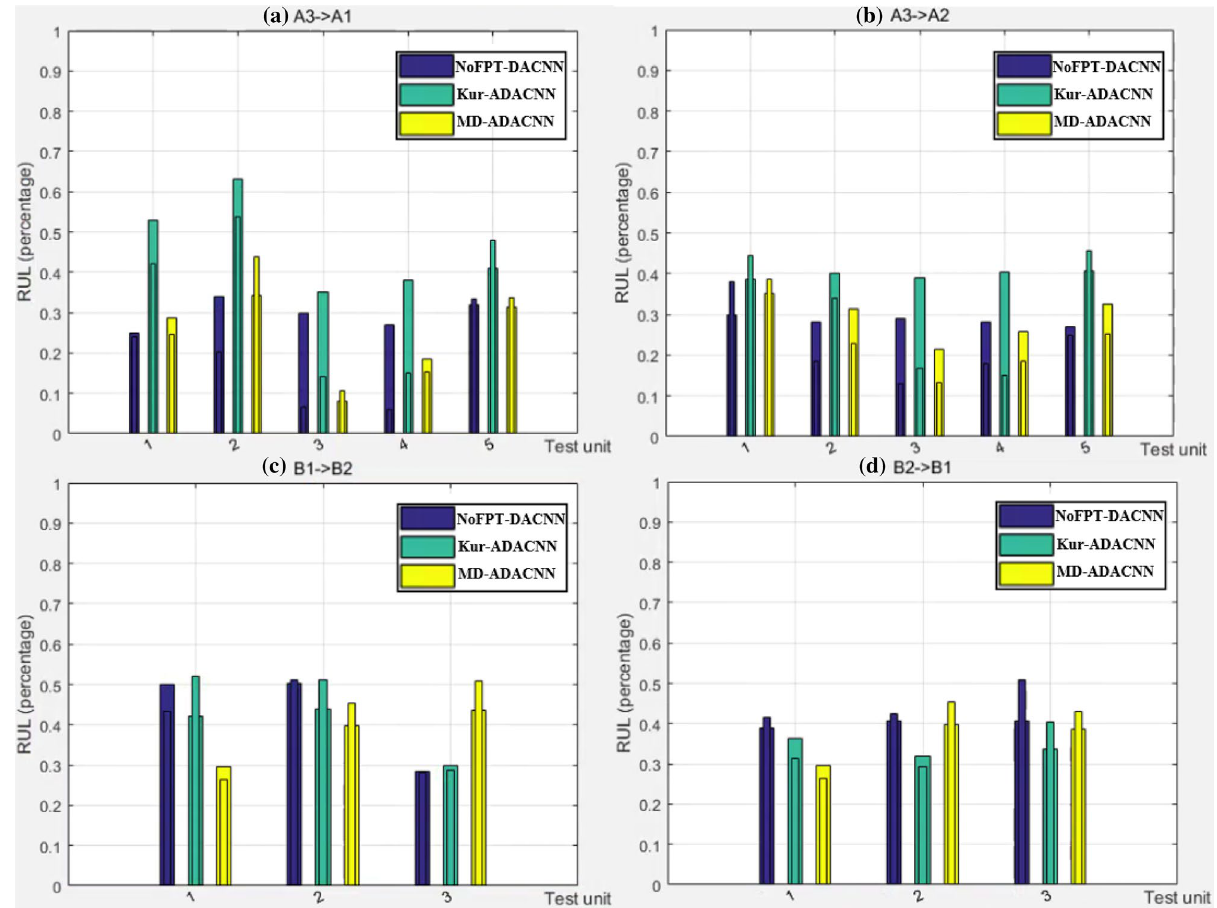
Figure 4. RUL estimation comparisons with different FPT detection mechanisms on FEMTO and XJTU-SY datasets: ( a ) A3 −→ A1, ( b ) A3 −→ A2, ( c ) B1 −→ B2, ( d ) B2 −→